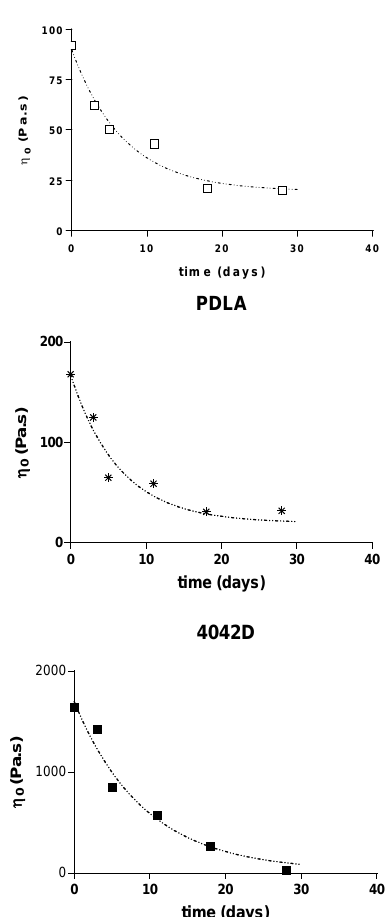
Figure 3. Zero shear viscosity evolution during composting of PLLA, PDLA and PLA4042D. A nonlinear regression using a one phase single exponential decay (dot lines):